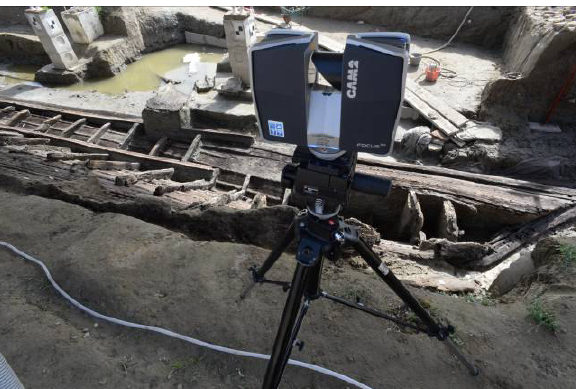
Figure 7. Laser scanner during the survey.